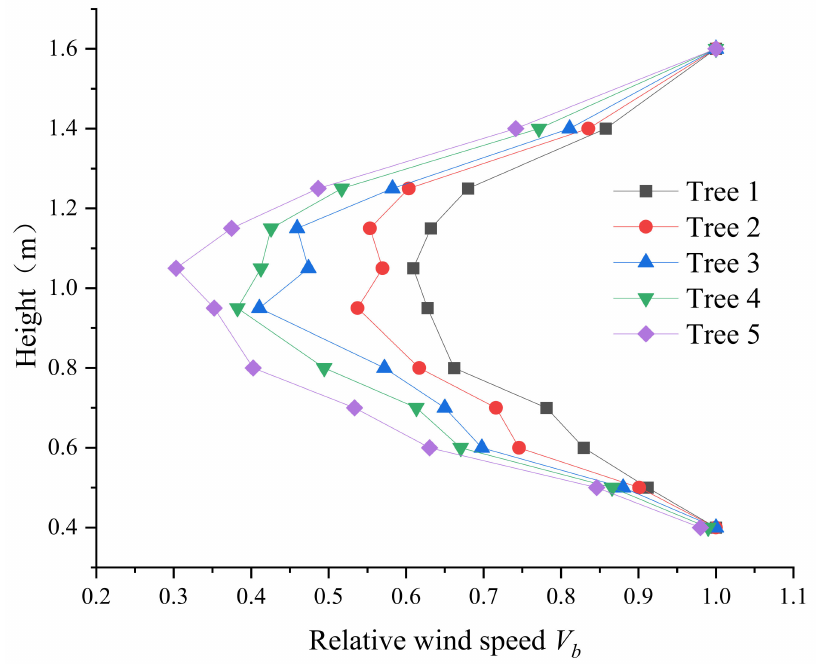
Figure 8. Relative wind speed at different canopy heights measured 0.1 m downwind of the